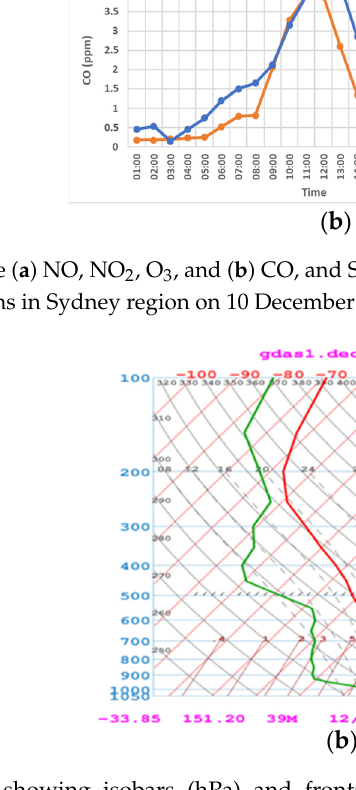
Figure 6. ( a ) Synoptic chart showing isobars (hPa) and frontal systems at 00:00 UTC on 10 December 2019; and ( b ) Skew-T-log-p diagram for the soundings taken in the Sydney region at the same time. ( http://www.bom.gov.au/australia/charts/archive/index.shtml (accessed on15 January 2020)).